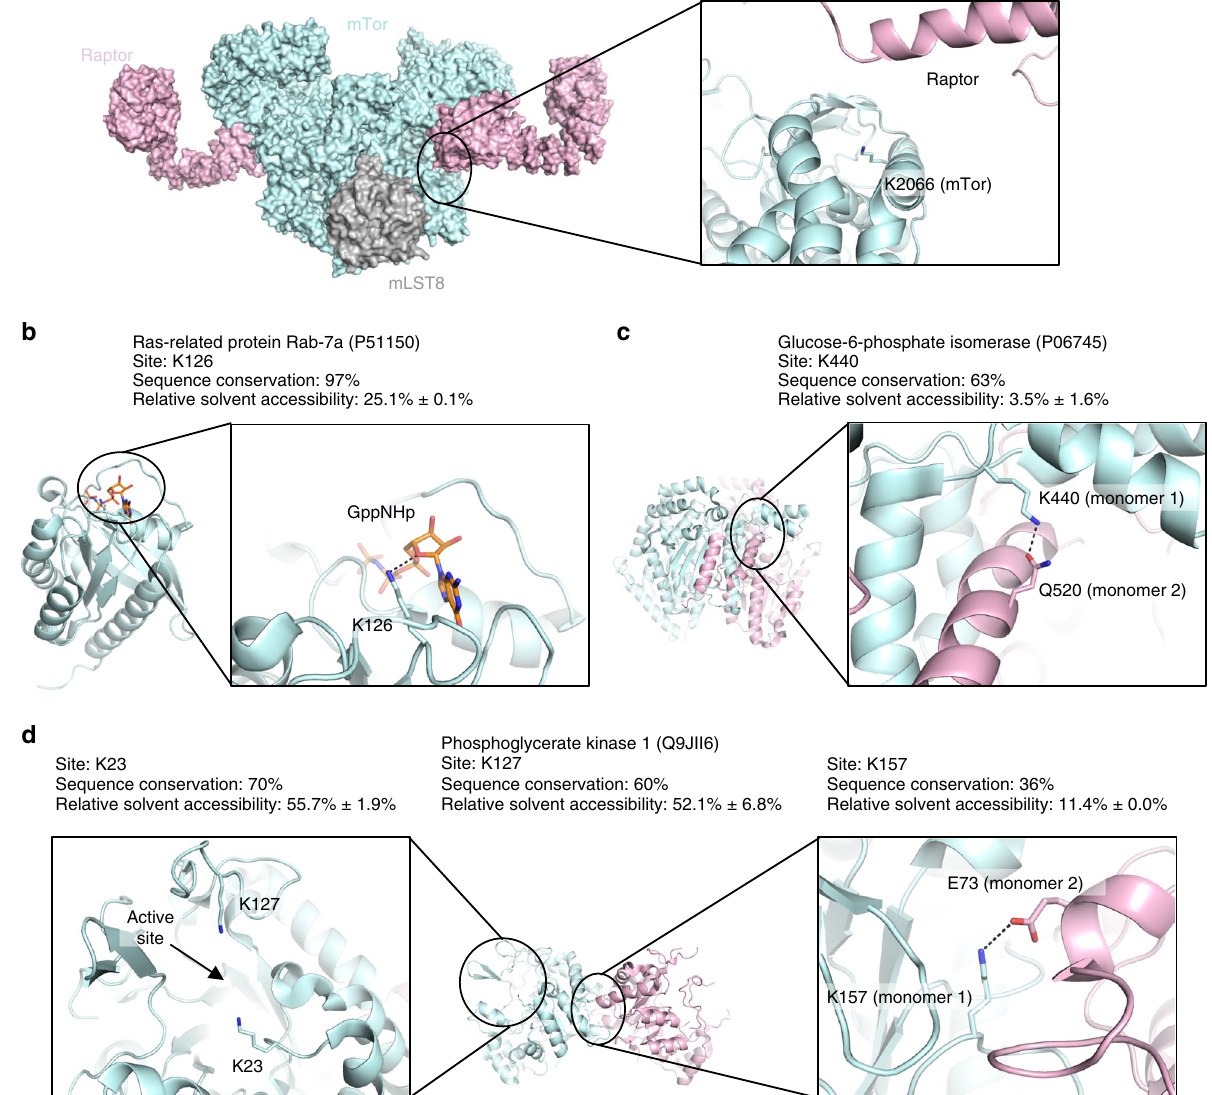
Fig. 4 Structural analysis of ISGylated sites. a ISGylated site Lys2066 of serine/threonine-protein kinase mTOR (uniprot ID: Q9JLN9) is shown on the structure PDB 5H64 [https://www.rcsb.org/structure/5H64] 73 . b ISGylated site Lys126 of Ras-related protein Rab-7a (uniprot ID: P51150) is shown on the structure PDB 1VG8 [https://www.rcsb.org/structure/1VG8] 74 . c ISGylated site Lys440 of glucose-6-phosphate isomerase (uniprot ID: P06745) is shown on the structure PDB 2CVP [https://www.rcsb.org/structure/2CVP] 75 . d ISGylated sites Lys23, Lys127, and Lys157 of phosphoglycerate kinase 1 (uniprot ID: Q9JII6) is shown on the structure PDB 4GAC [https://www.rcsb.org/structure/4GAC] 76 . a – d Relative solvent accessibility (RSA) is computed using all available structures. The mean and the standard deviation are reported. Hydrogen bonds and electrostatic interactions are represented by black dashed